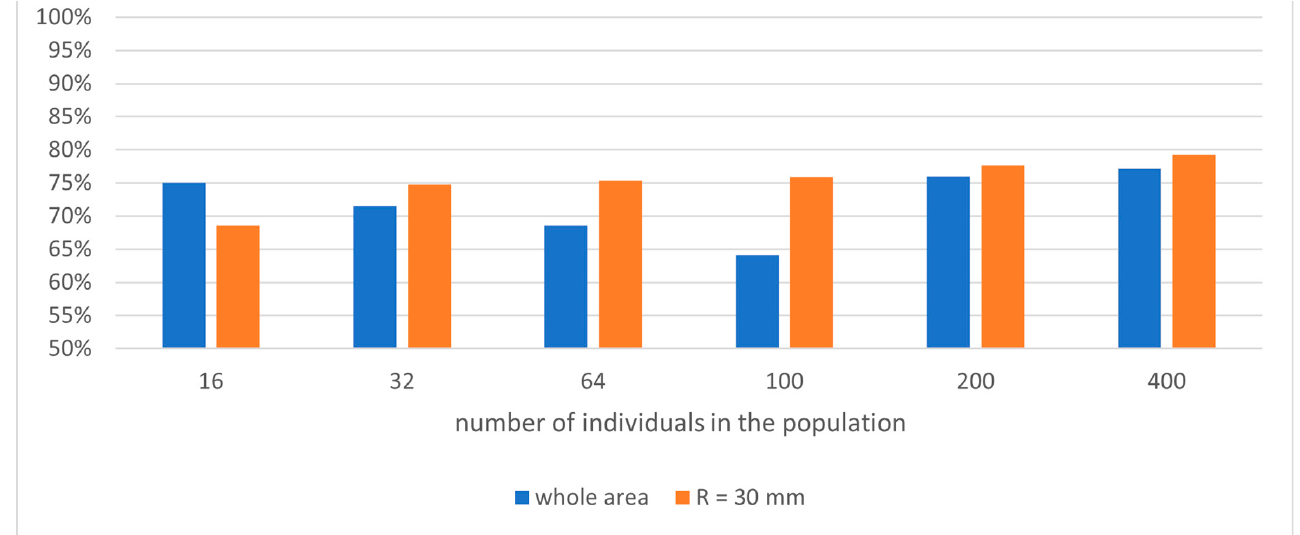
Figure 6. The share of correctly classified points of the entire pattern and in the area of radius R = 30 mm around the center of the marker grid, depending on population size for the adaptation function for the area in radius R = 30 mm around the center of the grid.